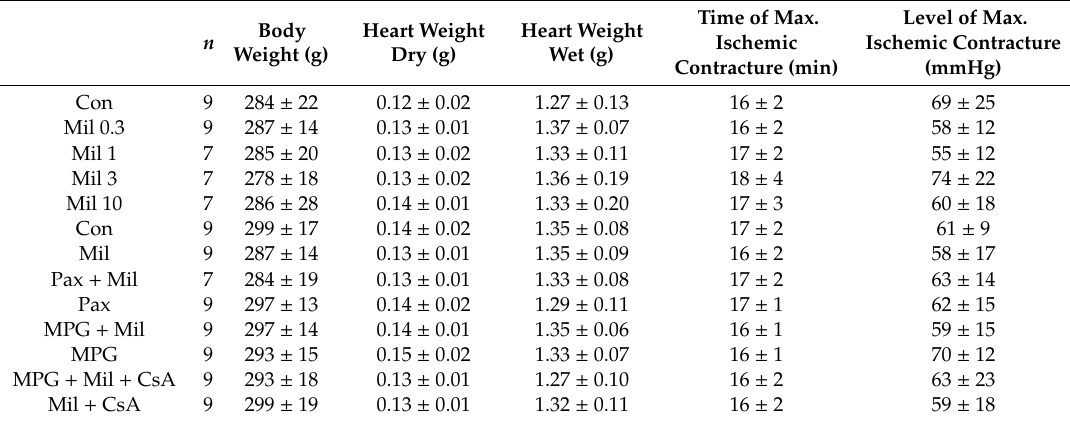
Table 1. Weights and ischemic